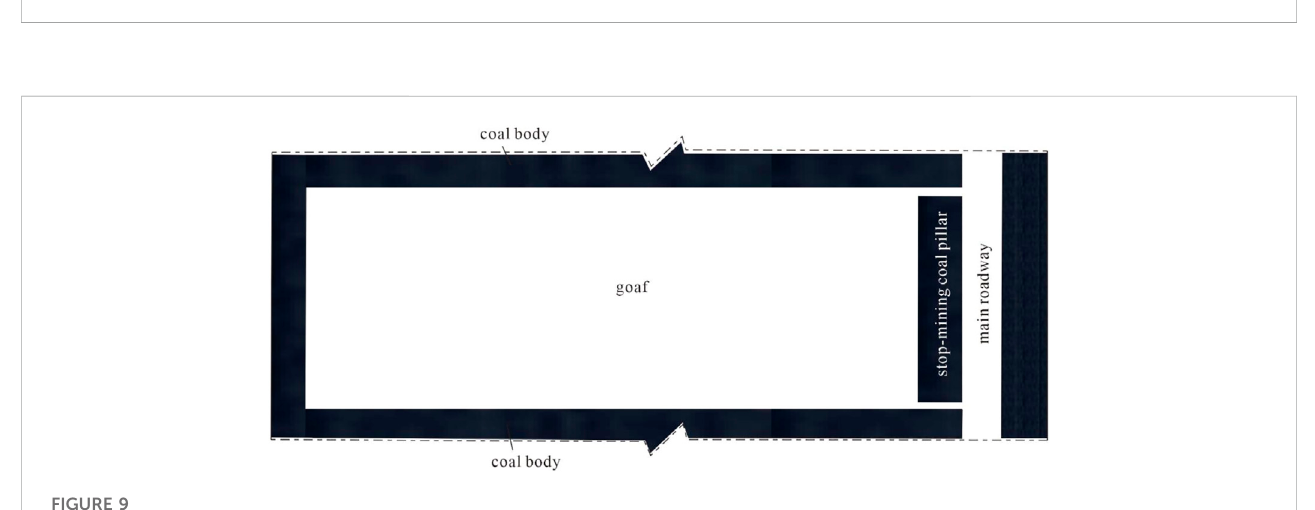
FIGURE 9 Schematic diagram of the coal